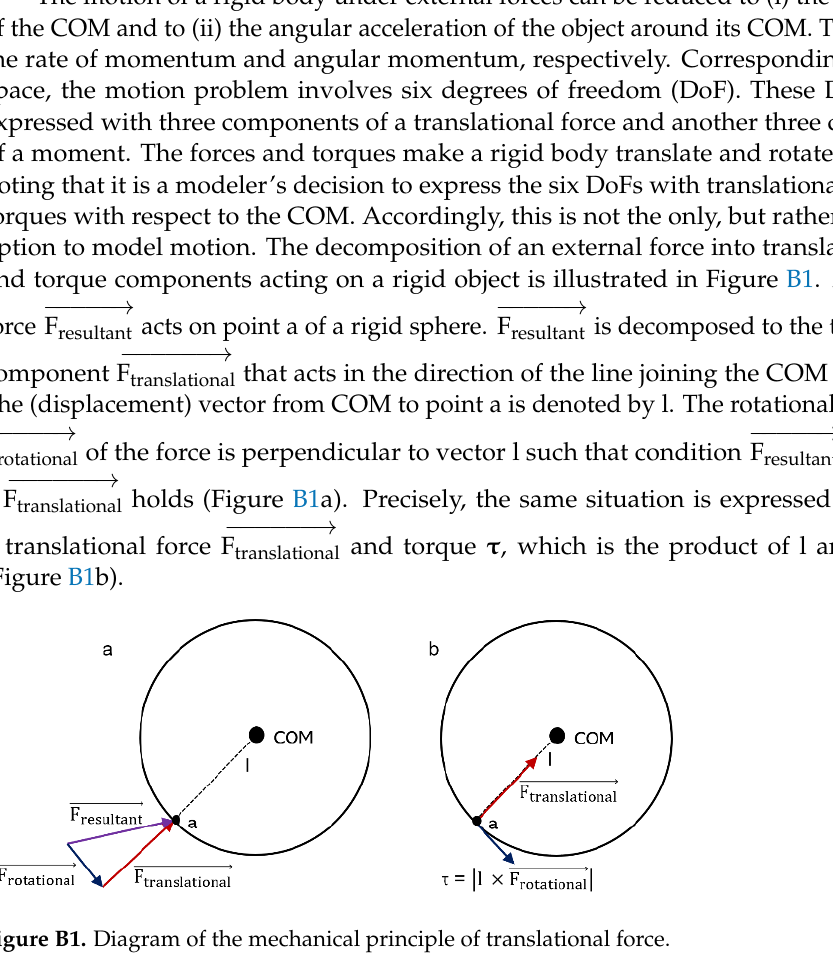
Figure B1. Diagram of the mechanical principle of translational force.